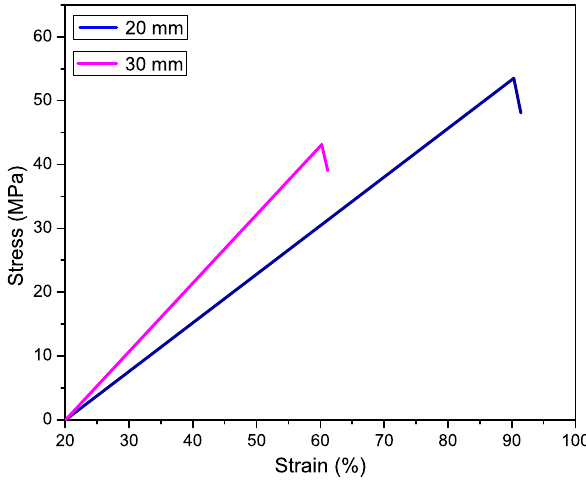
Figure 7. Tensile stress–strain curves of GL 20 mm and GL 30 mm of CTF